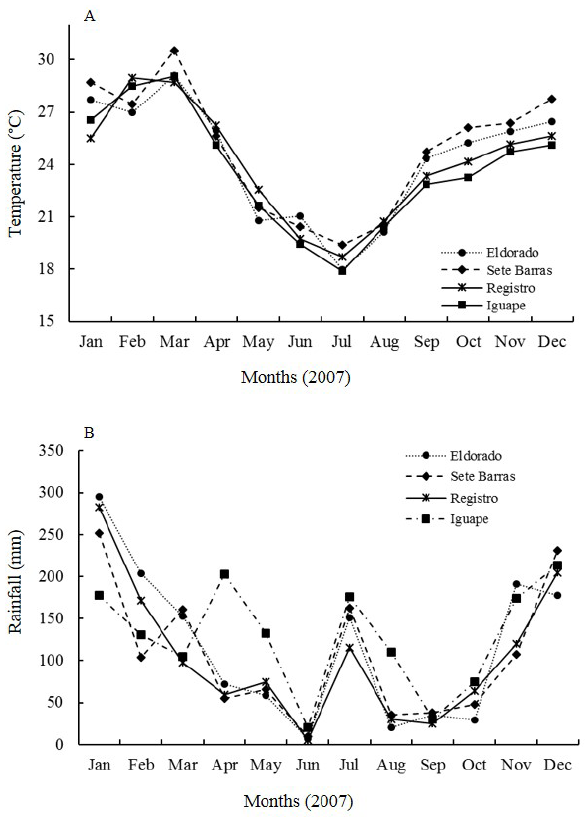
Figure 3. Mean water temperature ( A ) and rainfall ( B ) in Ribeira de Iguape river, São Paulo, Brazil, from January to December 2007.